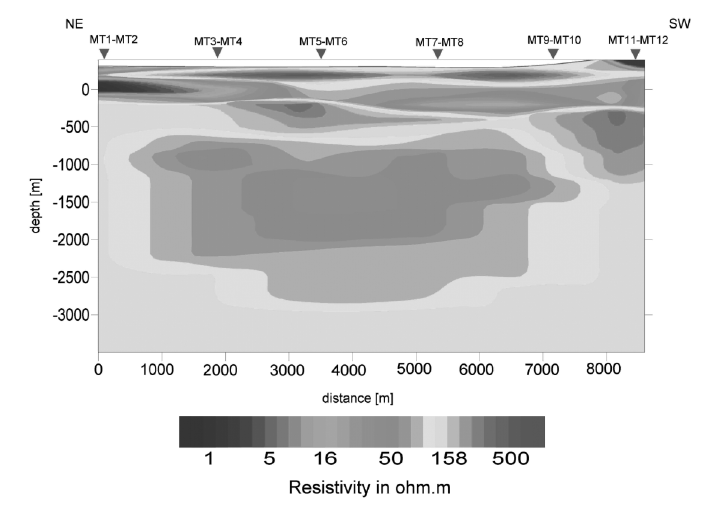
Fig. 3. Resistivity model resulting from the inversion of TM